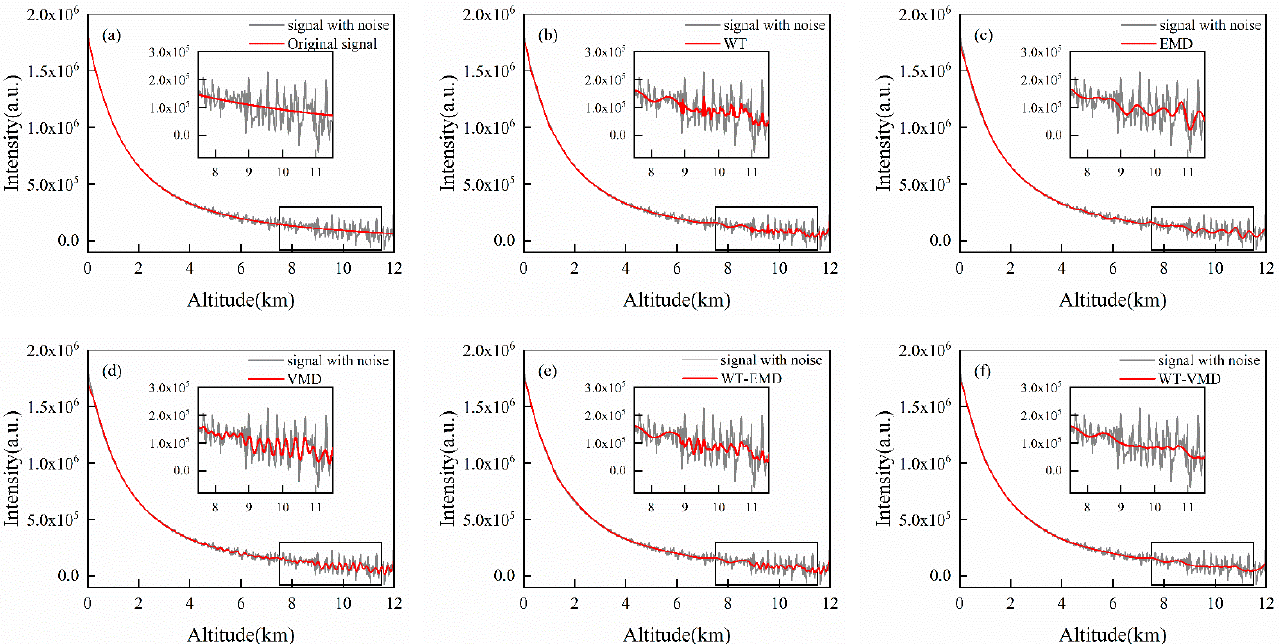
Figure 3. Experimental results of denoising of 100-pulse cumulative simulation signals (no pollu- tion): ( a ) original signal; ( b ) WT; ( c ) EMD; ( d ) VMD; ( e ) WT-EMD; ( f ) WT-VMD.